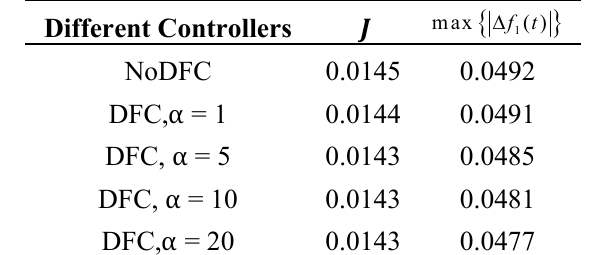
disturbance ( β = 0).